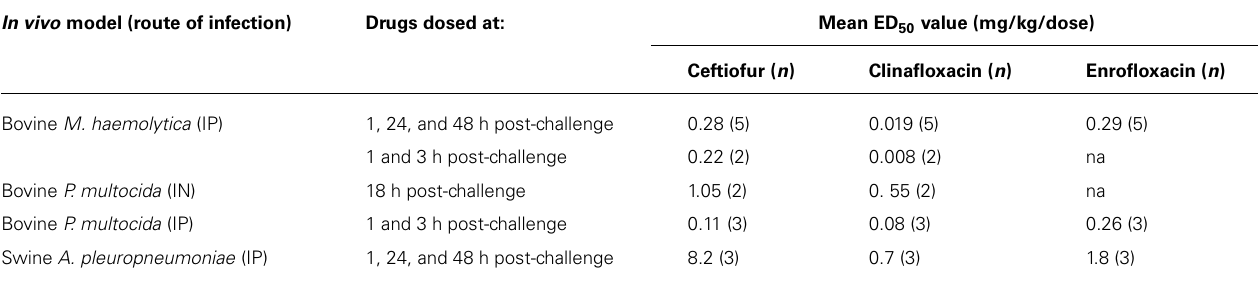
Table 4 | Murine drug efficacy